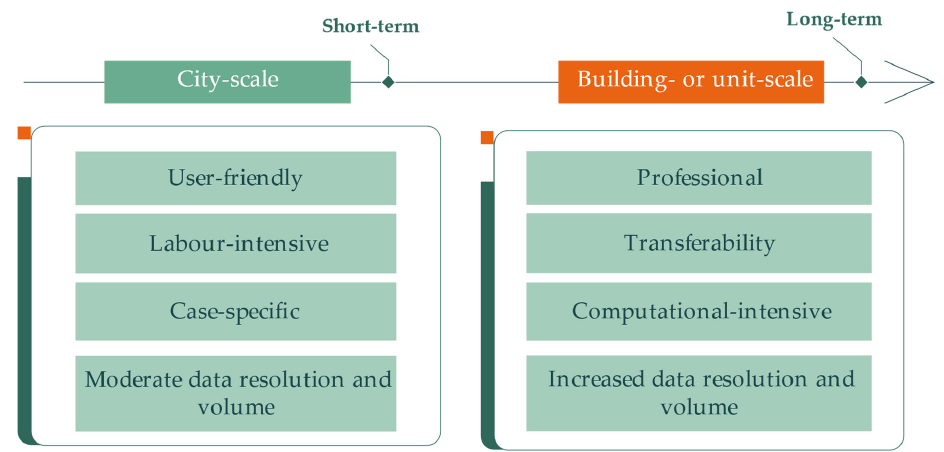
Figure 7. The overview of 3DPV development.